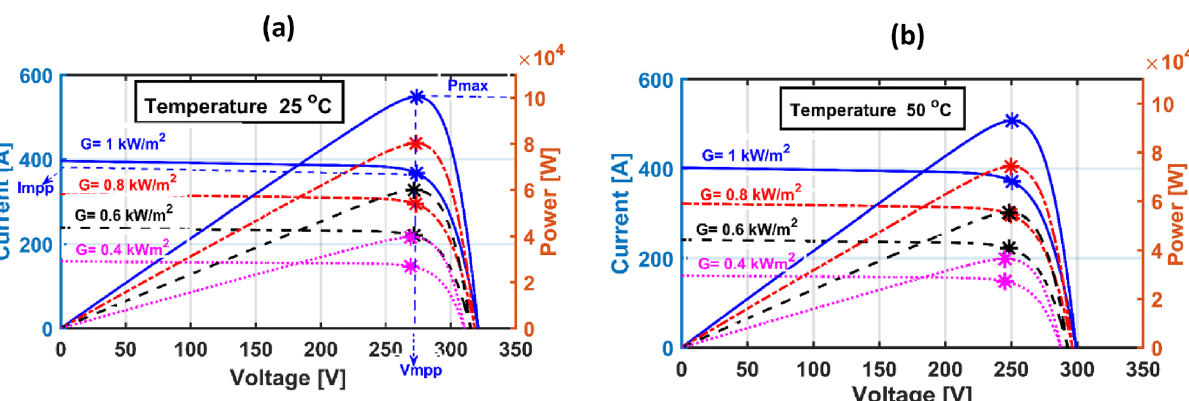
Figure 3. I-V and P–V characteristic curves for a 100 kW PV system ( a ) at 25 °C with multiple irradiances, ( b ) at similar previous irradiances with a specified temperature of 50 °C.